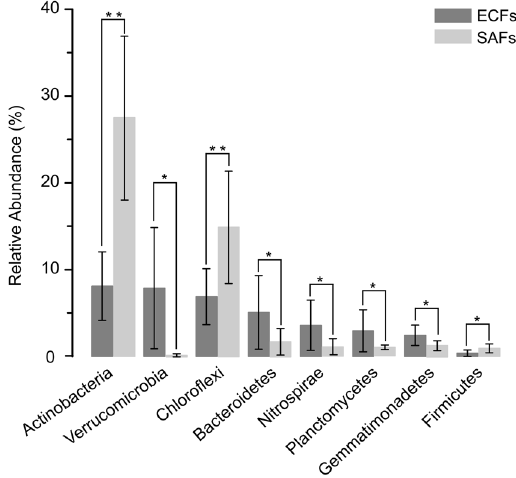
Figure 7. Differential analyses of bacteria in the hyphosphere soils of ectomycorrhizal fungi (EMFs) and saprophytic fungi (SAFs) at the level of phylum, and the phyla with significant differences between EMFs and SAFs were listed. p -values are derived from use of the T- test. * p < 0.05; ** p <